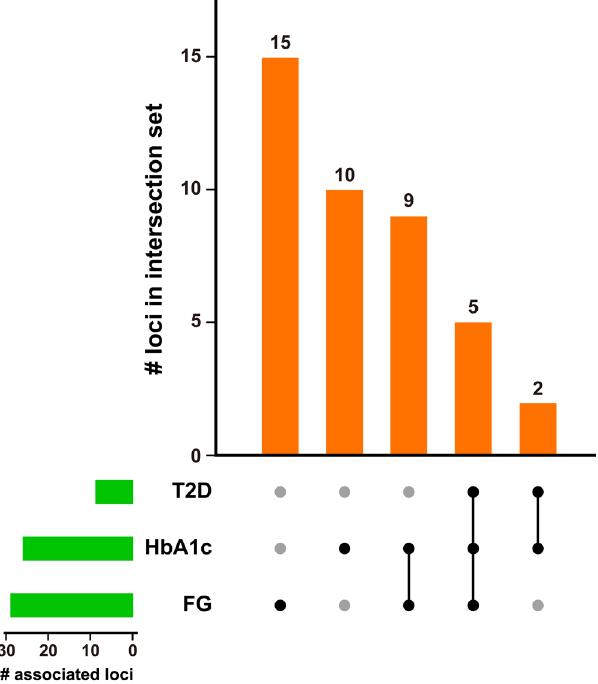
Fig. 3 Overlapping loci within glycemic traits. The upset plot 59 summarizes shared loci of three glycemic traits. The dot-and-line chart in the bottom combination matrix indicates intersections between three traits. For example, the second column from the left indicates a set of loci only associated with HbA 1c , while the middle column indicates loci associated with both HbA 1c and FG. The upper bar chart shows the number of associated loci in each set. The lower left horizontal bar chart represents the number of loci associated with T2D (7), HbA 1c (26), and FG